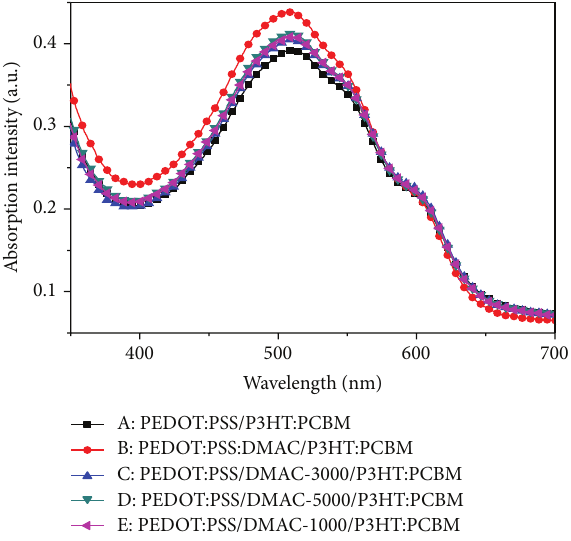
Figure 5: The absorption spectrum of PEDOT:PSS/P3HT:PCBM thin film. A: only PEDOT:PSS solution on ITO at the speed of 3000 rpm. B: the PEDOT:PSS and DMAC mixed in a ratio of 4 :1(v/v) at the speed of 3000 rpm. C, D, and E: the PEDOT:PSS buffer layer modified by DMAC at speed of 1000, 3000, and 5000 rpm.